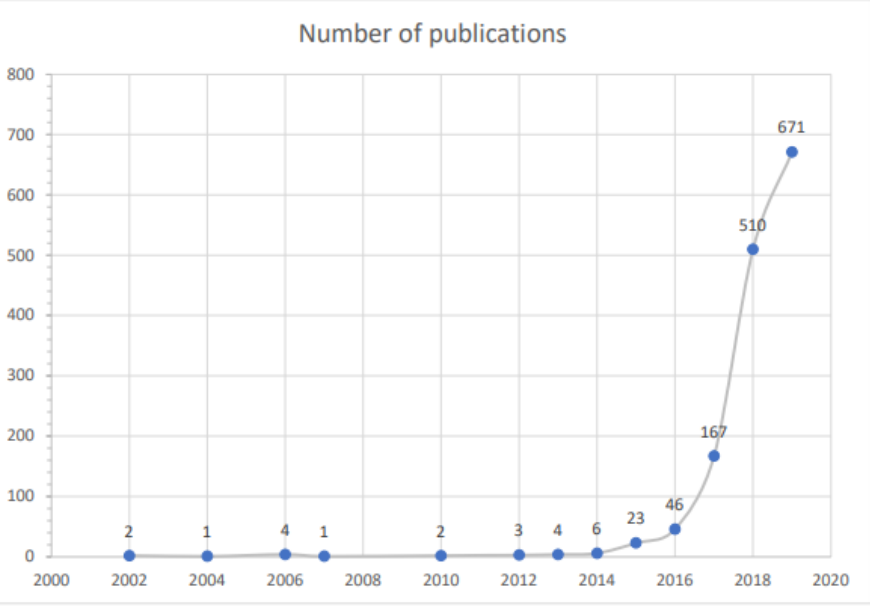
Figure 2. Number of scientific publications on the edge computing topic versus time